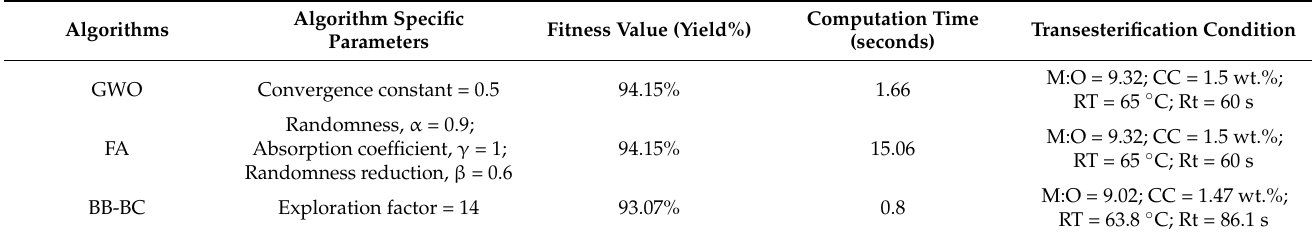
Table 6. Optimization of transesterification parameters using three